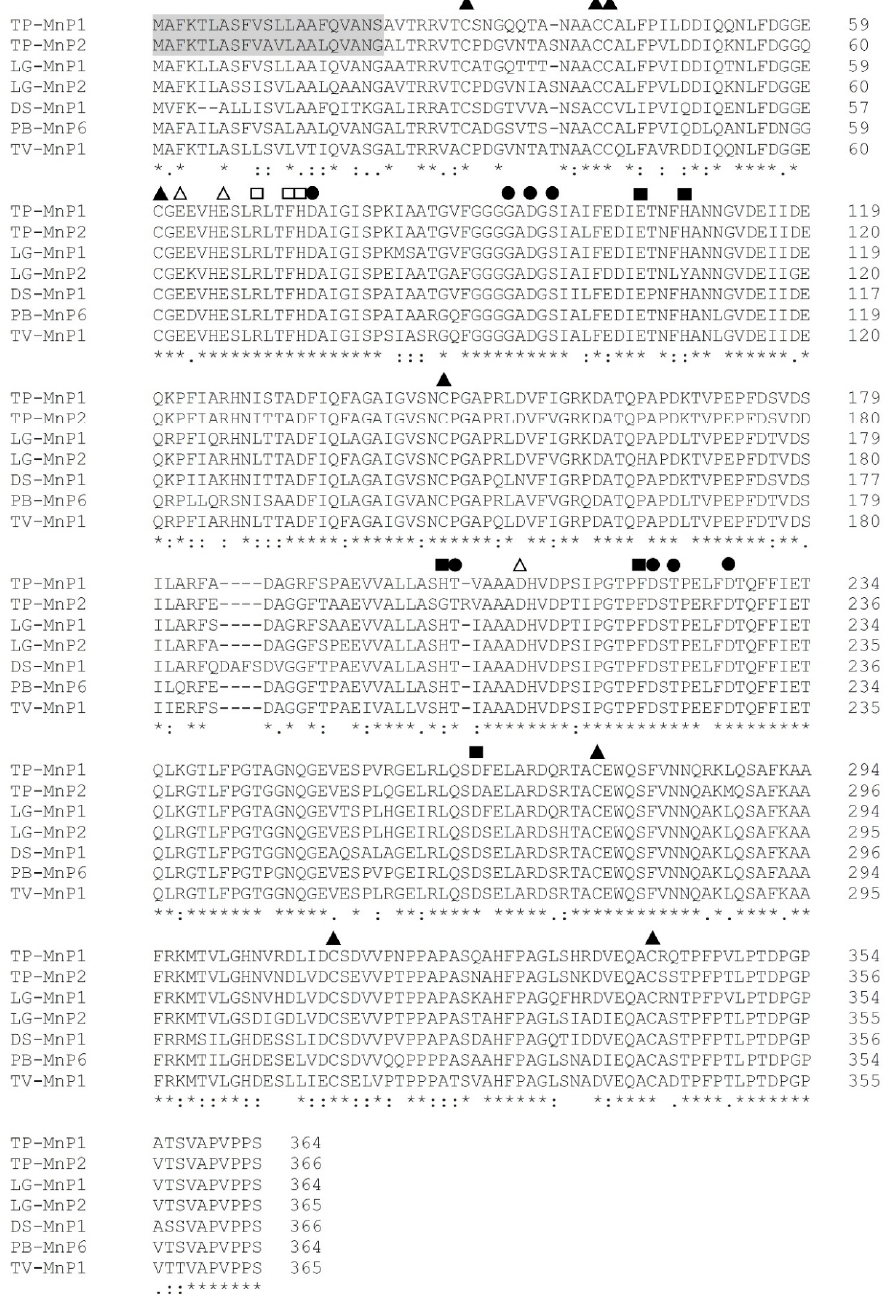
Figure 2. Deduced amino acid sequences of two new mnp genes. The shaded amino acid sequence is the predicted signal peptide. Eight conserved cysteine residues are indicated by triangles ( ). Conserved heme pocket residues are indicated by solid rectangles ( ). Mn 2+ binding sites are indicated by hollow triangles ( ). Ca 2+ binding sites are indicated by circles ( ). Oxidation sites of the substrate are indicated by hollow rectangles ( ). TP: Trametes polyzona ; LG: Lenzites gibbosa ; DS: Dichomitus squalens ; PB: Polyporus brumalis ; TV: Trametes versicolor . A putative signal peptide was analyzed using SignalP 4.0 [25].